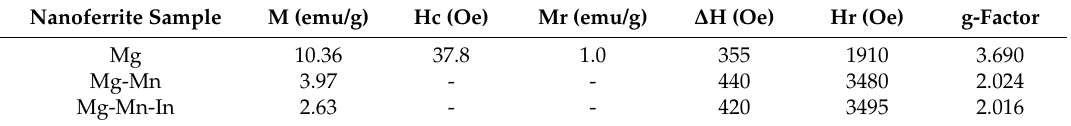
Table 1. Magnetic parameters and microwave properties of three Mg-based